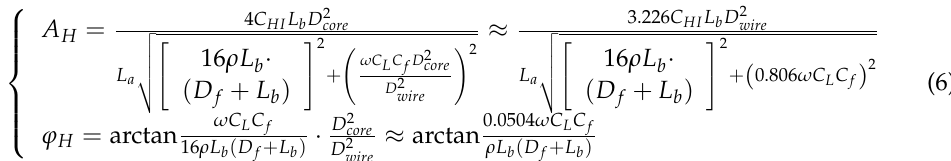
0.2 0.3 0.4 0.5 0.6 0.7 0.8 0.9